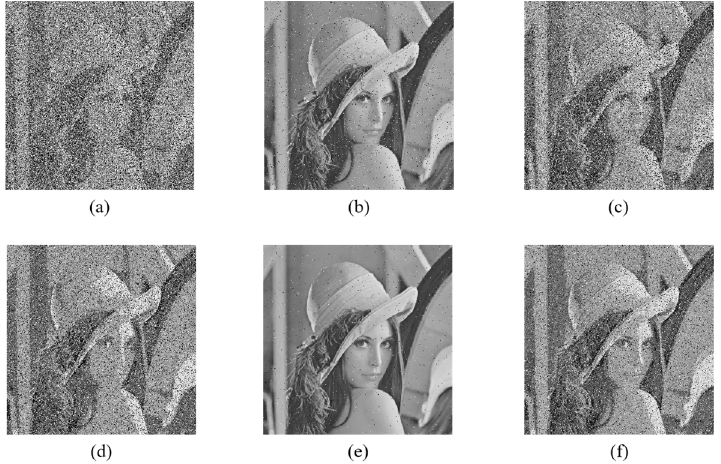
Figure 15. ( a – c ) are the restoration results after adding 0.01 gaussian, salt and pepper and speckle to the ciphertext image using the comparison method. ( d – f ) are the restoration results after adding 0.01 gaussian, salt and pepper, and speckle to the ciphertext image using the proposed method.